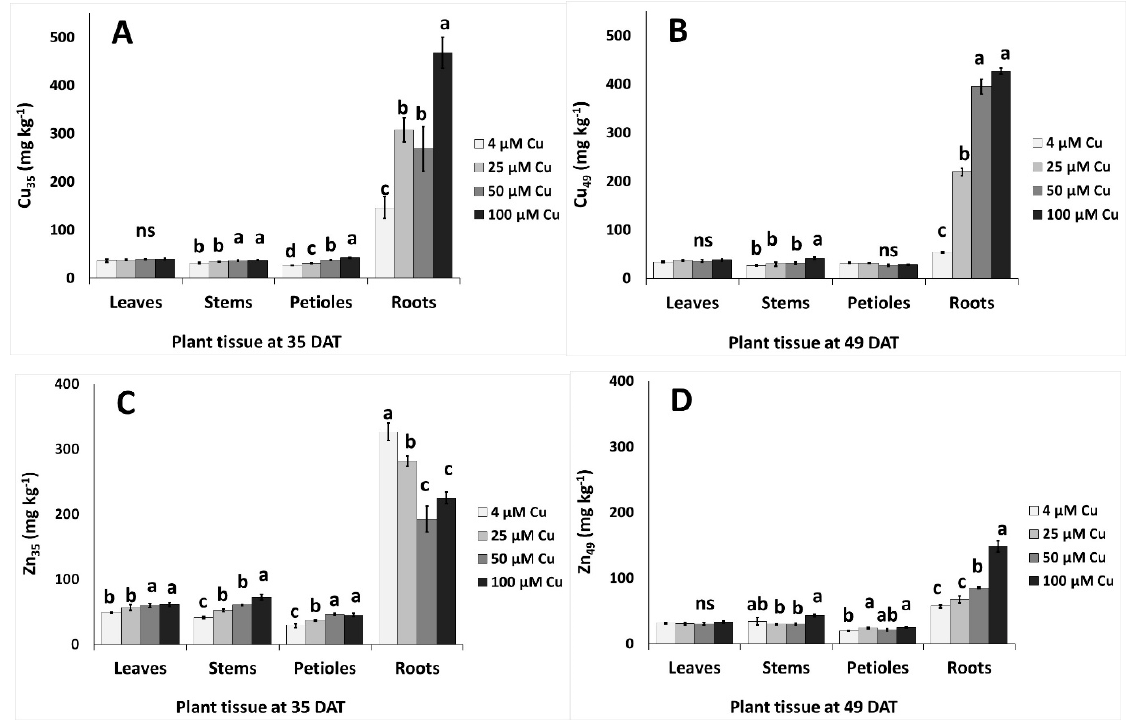
Figure 5. Effect of increasing copper (Cu) concentration (4–25–50–100 µ M Cu 2+ ) in the nutriment solution and sampling date after transplanting (DAT, 35 days and 49 days) on the content of micronutrients in different organs of pelargonium plants grown hydroponically in perlite. ( A,B ) Copper–Cu, and ( C,D ) zinc–Zn. Significant differences ( p < 0.05) among Cu concentrations at each sampling date are indicated by different letters; ns indicates non-significant. Error bars show SE ( n =